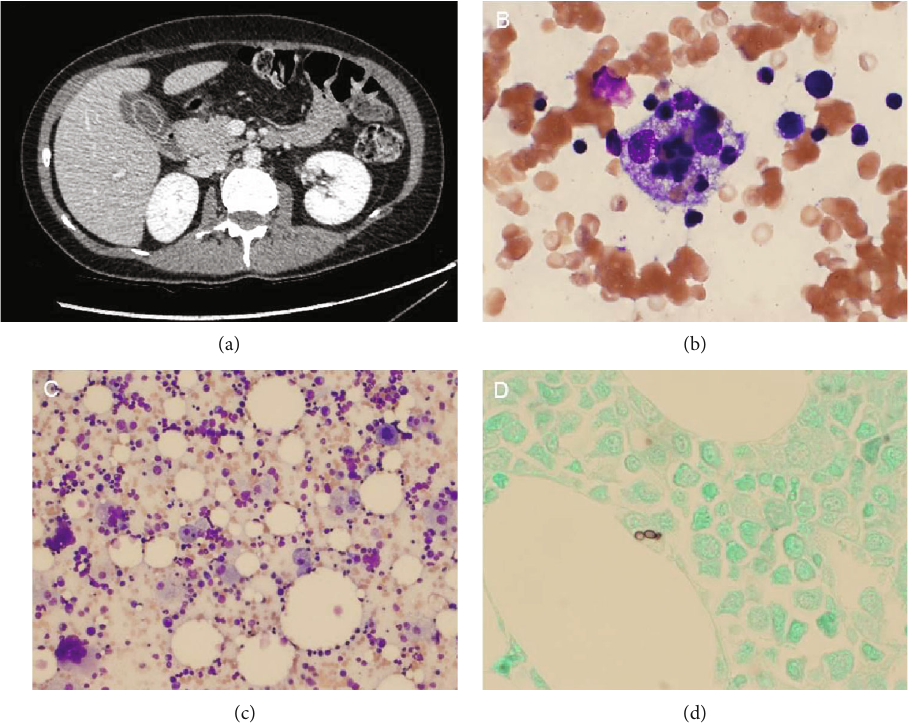
Figure 2: (a) CT abdomen on admission reveals edematous gallbladder which was later found to have evidence of Histoplasma capsulatum . (b, c) Bone marrow aspirate reveals hemophagocytosis. (d) GMS stain of bone marrow core biopsy positive for